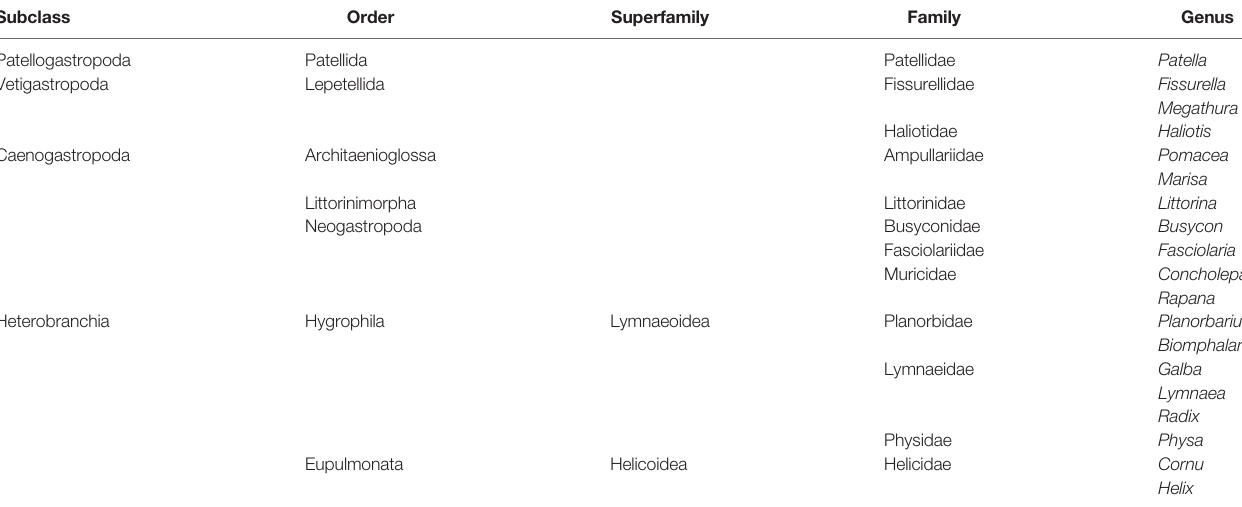
TABLE 1 | Simpli fi ed taxonomy of the Gastropoda, showing the relative position and context of the species mentioned in the text.